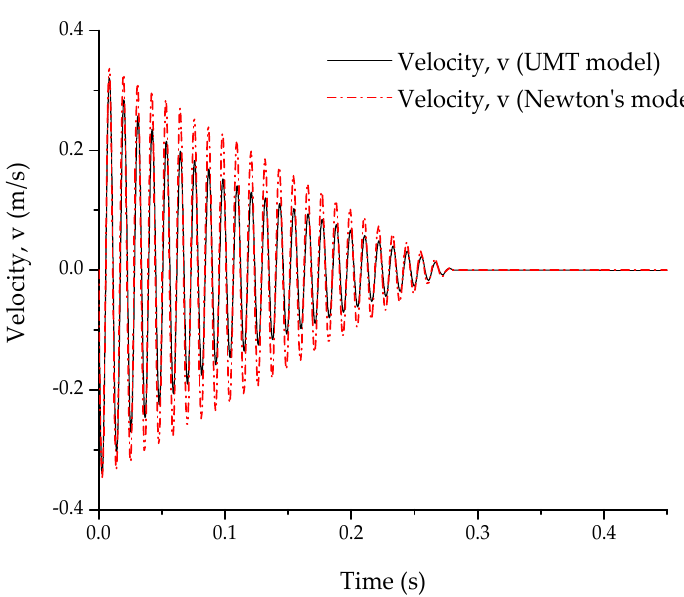
Figure 4. Velocity versus time for a damped oscillator in the presence of contact surface friction.